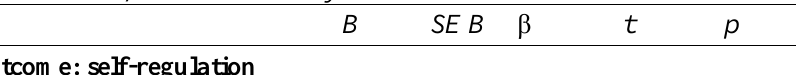
Model 1: analysis of the mediating role of self-regulation in the relationship between supportive/engaged and early mathematics B SE B β t p Outcome: self-regulation Constant -92.78 43.22 -2.15 .037 Supportive/engaged 1.20 0.33 <.001 Age of the child 0.66 Educational level of the mother 3.54 Outcome: early mathematics Constant -56.56 14.45 Self-regulation 0.15 Supportive/engaged Age of the child